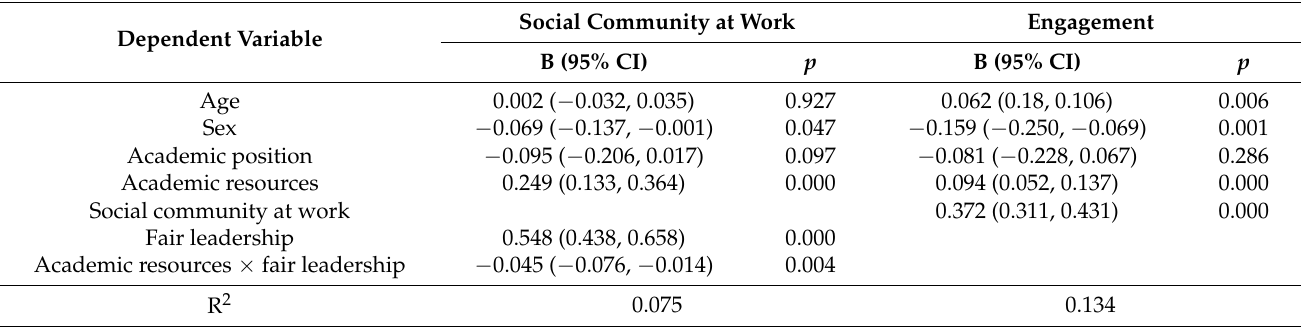
Table 4. Results of regression analysis testing Hypothesis